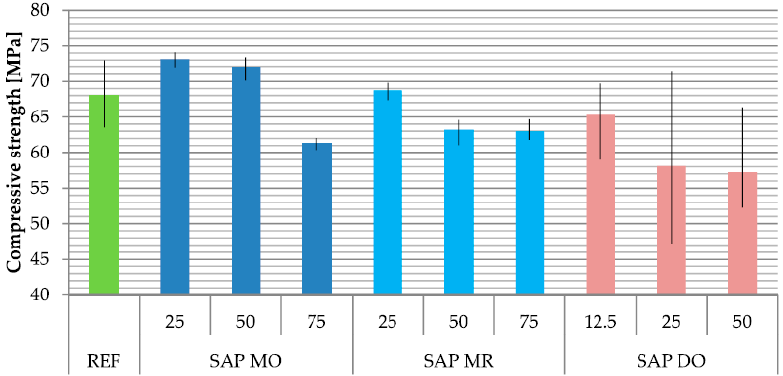
Figure 7. The average compressive strength of the tested compositions of concrete composites.